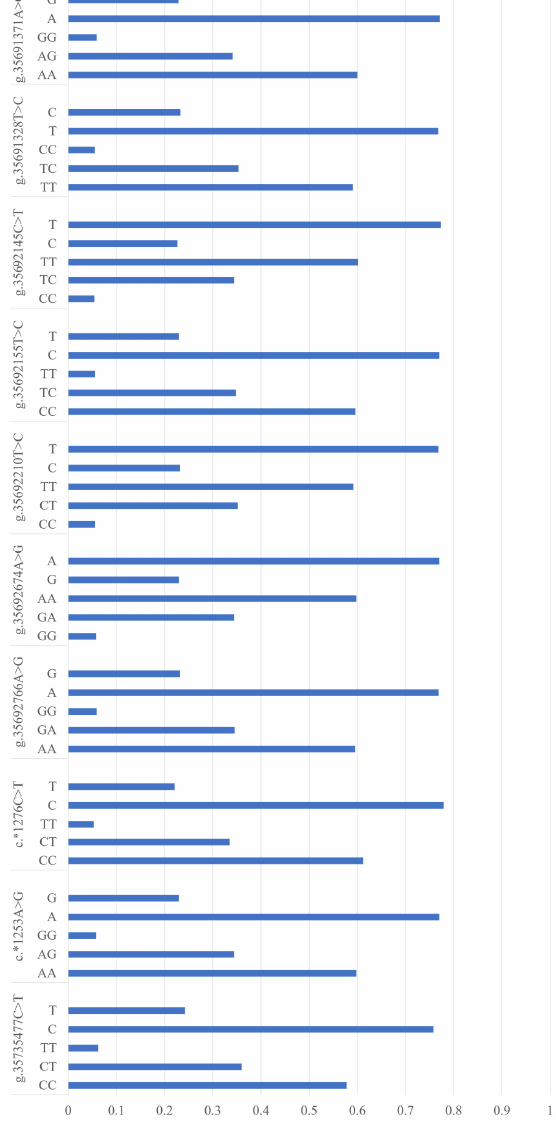
Figure 1. Allelic and genotypic frequencies of the ten single nucleotide polymorphisms (SNPs) in nucleobindin 2 ( NUCB2 ). The “*” shows the SNPs located in the 3’untranslated region (UTR).